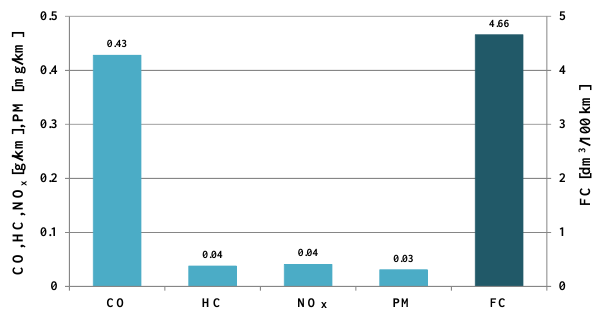
Fig. 7. Net road emission of CO, HC, NO x and PM in road tests as well as fuel consumption from the whole test